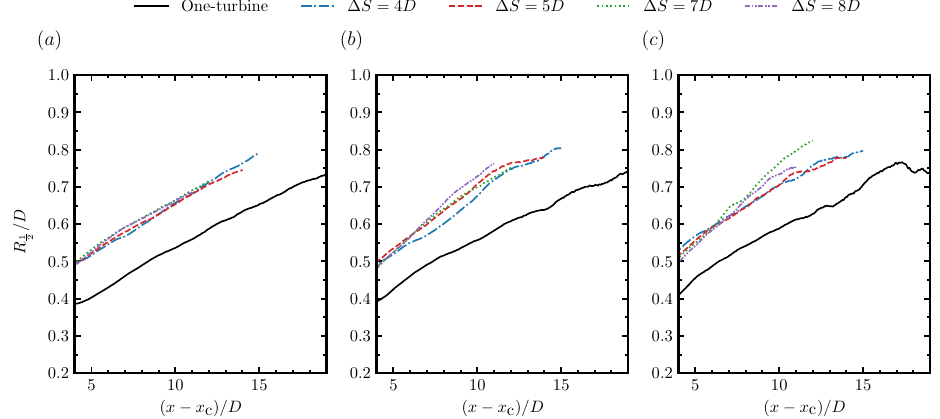
Figure 10. Streamwise variations of the half width R 1 fitting the time-averaged velocity deficit using the Gaussian distribution, for ( a ) inflow1, ( b ) inflow2, and ( c ) inflow3,